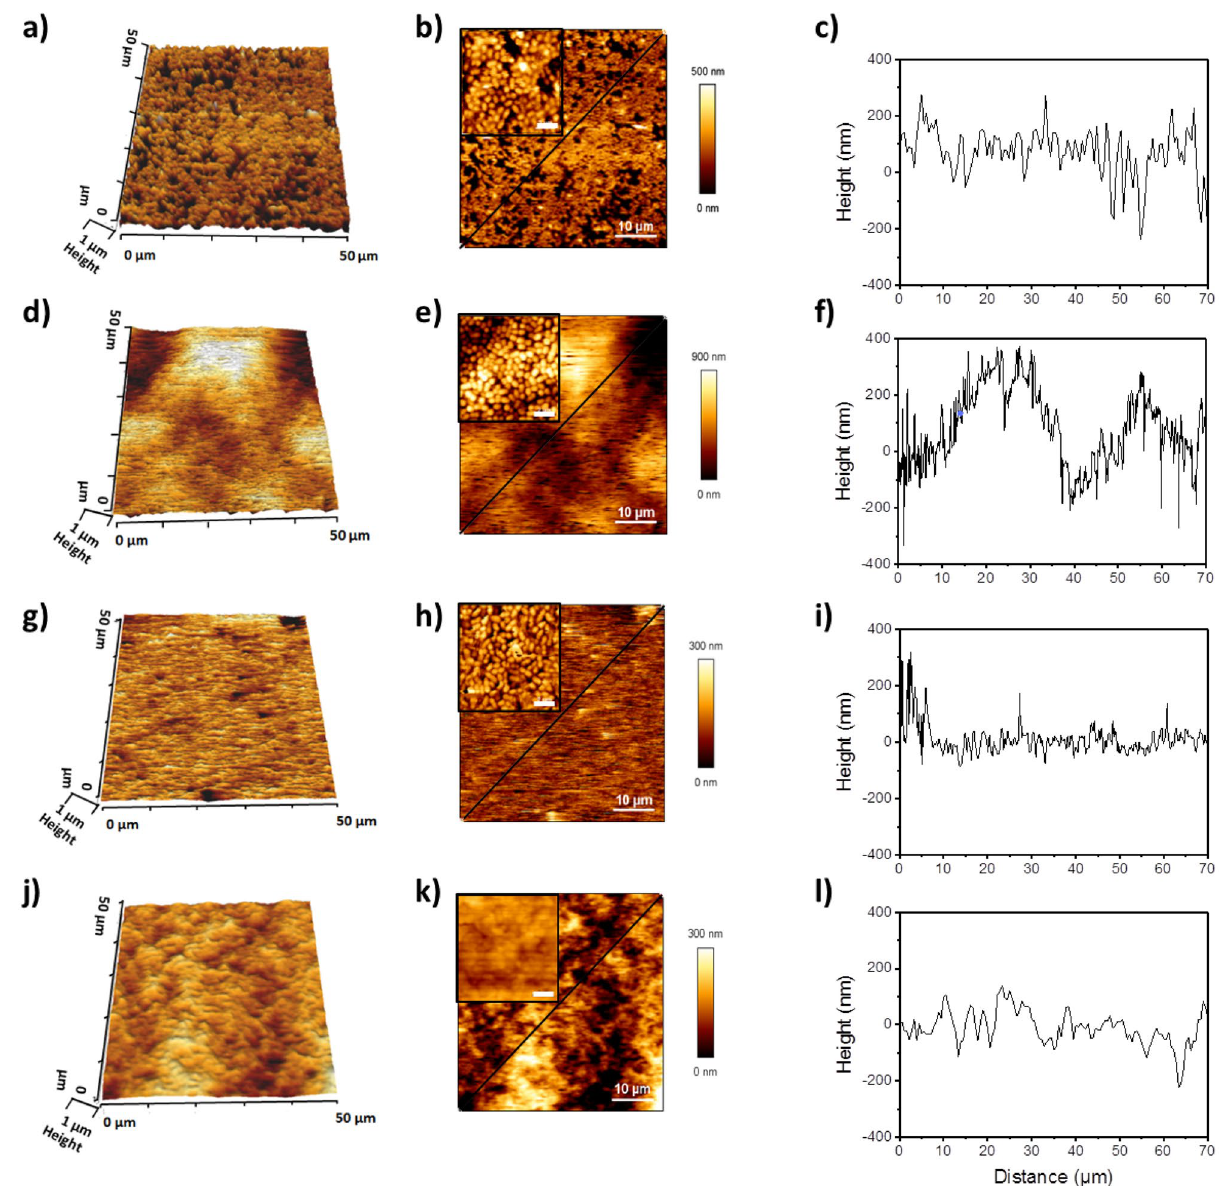
Figure 2. Topography analysis of 24-h L . lactis biofilms using AFM. High-resolution 3D images were recorded for an area of 50 µm × 50 µm with 16 × 16 pixels. Cross section profiles are indicated by the black lines. Studied strains: Pil − VE17061 ( a – c ), Pil ++ VE17176 ( d – f ), Pil − Mub − TIL1230 ( g – i ) and Pil + Mub + TIL448 ( j – l ). The scale bar in the insert b, e, h and k, corresponds to 2